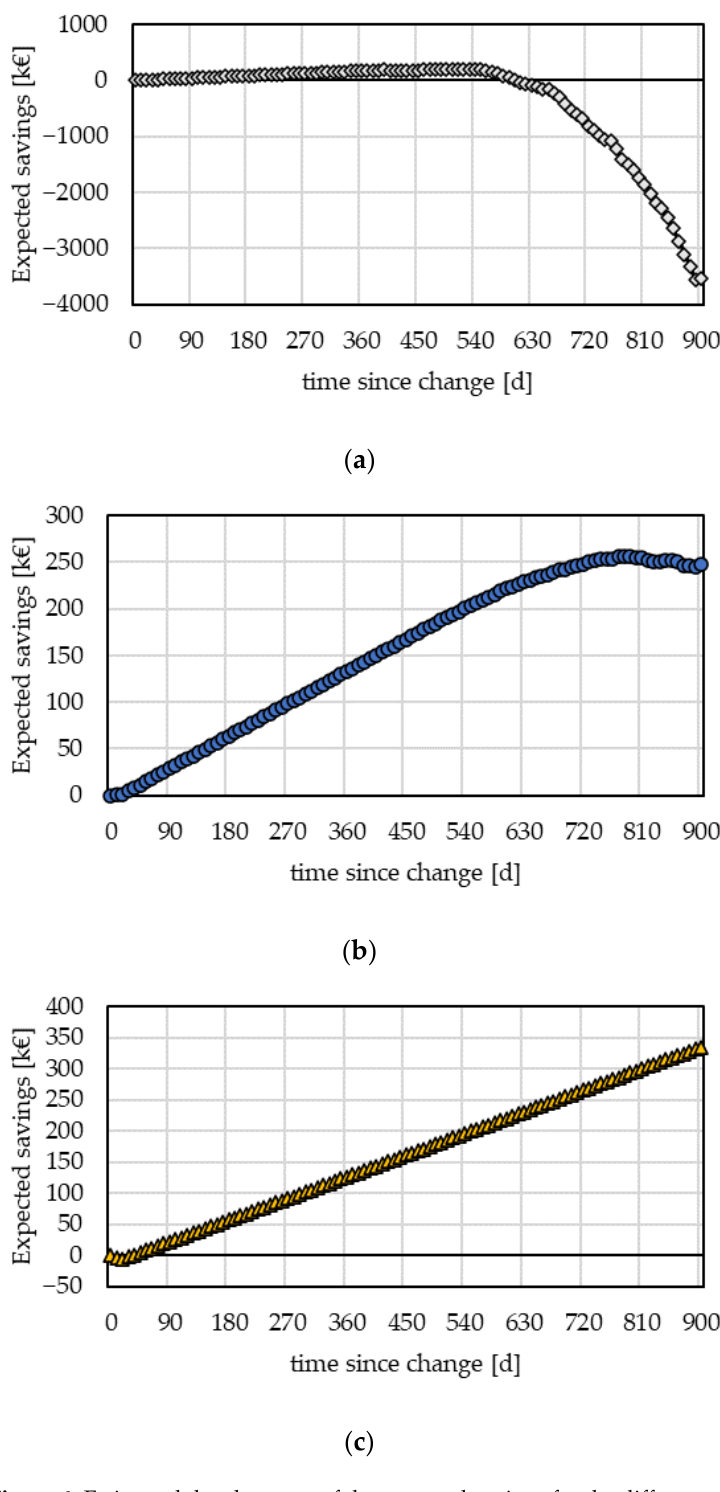
Figure 6. Estimated development of the expected savings for the different switching strategies within the use-case. ( a ) Immediate switch. ( b ) Test and switch. ( c ) Test, then switch.